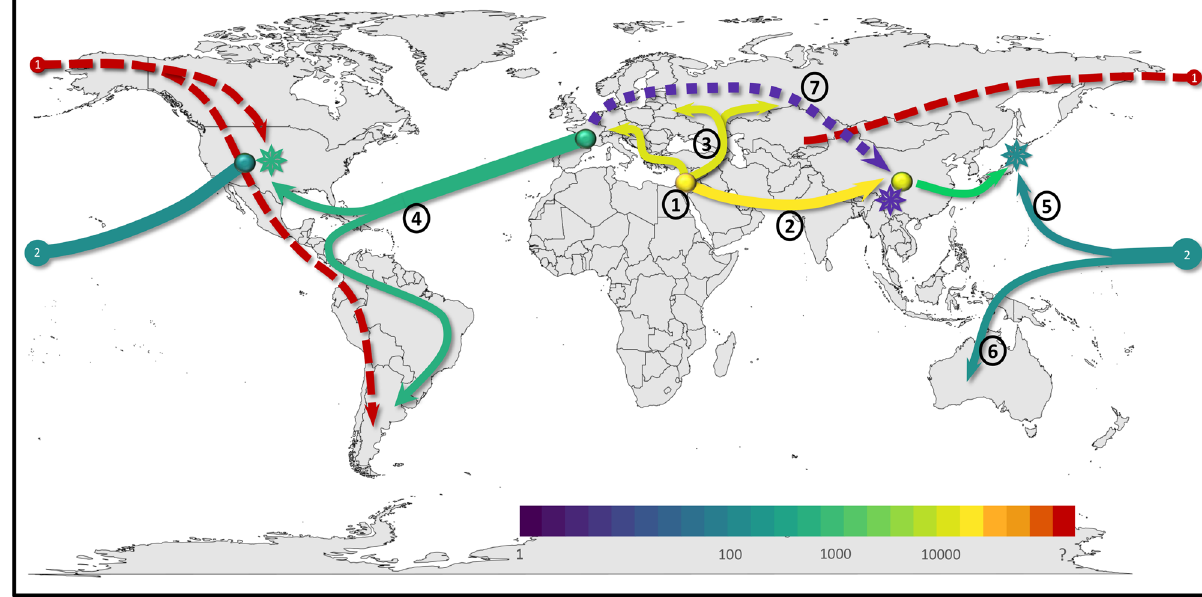
Fig. 5 Worldwide migration patterns hypothesis over time and throughout the world. Different colors represent the approximate time periods when the proposed events occurred. ( 1 ) Firstly, we have the Fertile Crescent being the origin of the pathogen. ( 2 ) Then, it splits, migrating to East Asia. ( 3 ) Migration of powdery mildew across all Eurasia. ( 4 ) During the colonization of America, Eurasian wheat powdery mildew was introduced to the Americas, which recombined with a distantly related powdery mildew, followed by isolation on this continent. ( 5 – 6 ) Later, the USA started exporting wheat to Japan and Australia, helping the pathogen migrate to both places. In Japan, because of the breeding of the American wheat lines with Japanese landraces, powdery mildew recombined between the East Asian and American populations and quickly got fi xed because of adaptation to these new lines. ( 7 ) Finally, recent various levels of recombination between East Asian and European ancestry have been observed in the Chinese mildew population. The stars represent recombination events of populations that were fi